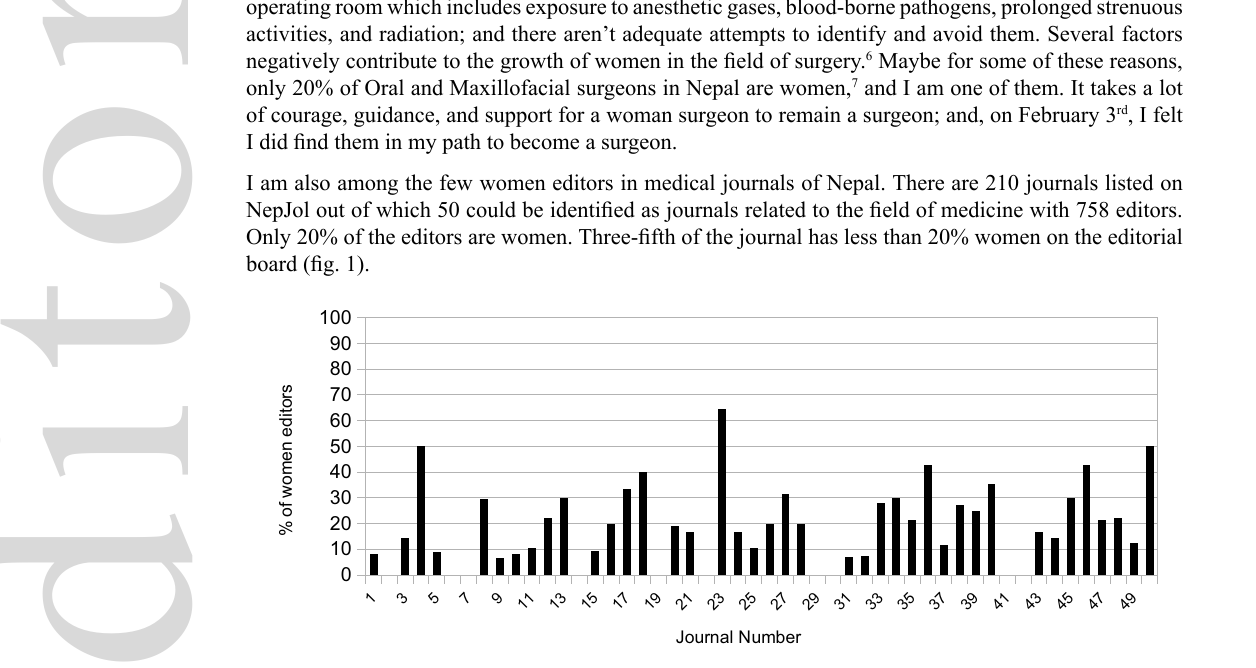
Figure 1: Percentage of Women in Editorial Team of Medical Journals of Nepal